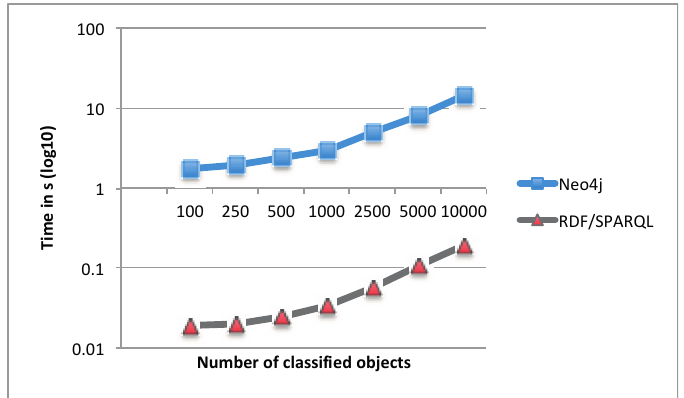
Figure 10. Classification time for Neo4j vs.